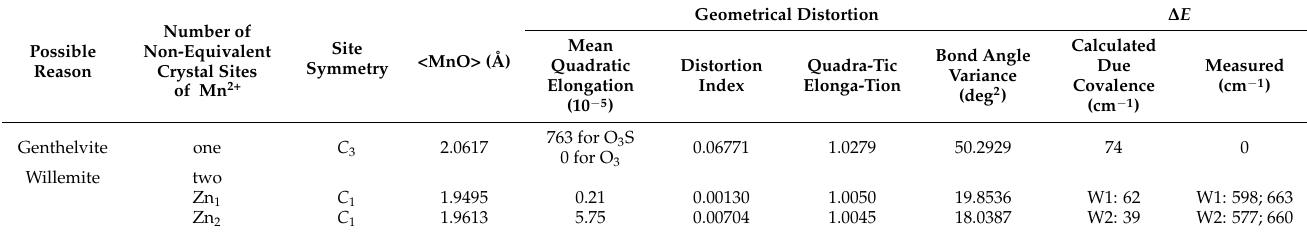
Table 11. The possible reasons for ∆ E